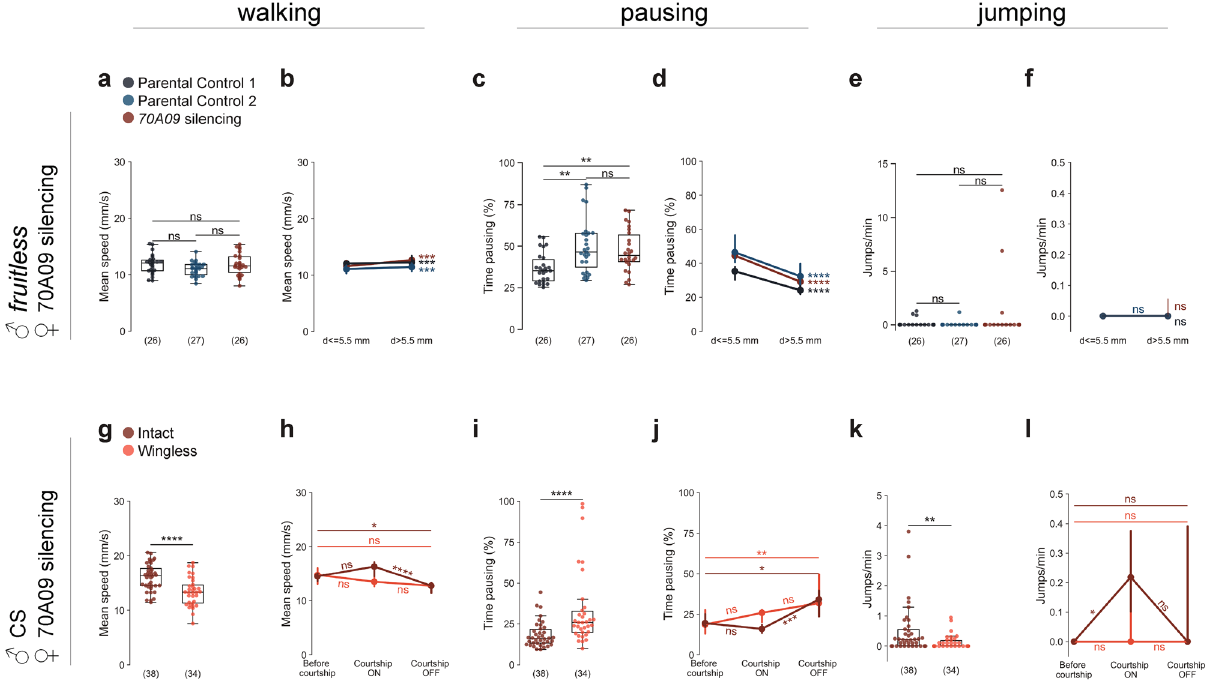
Figure 5. 70A09-silenced females do not escape when coupled with courtship-impaired males. ( a – f ) Non courting fruitless mutant males paired with females of each of the genotypes: w-/UAS > STOP > kir2.1; otd nls:FLPo/ + ; + (Parental Control 1), w-; + ; 70A09-GAL4/ + (Parental Control 2) and w-/UAS > STOP > kir2.1; otd-nls:FLPo/ + ; 70A09-GAL4/ + (70A09 silencing). ( g – l ) Canton-S males intact and with wings removed (wingless) paired with silenced 70A09 females (70A09 silencing). ( a and g ) Female mean walking speed (4–50 mm/s), ( c and i ) female pausing and ( e and k ) number of jumps per minute, during courtship ON periods. ( b and h ) Female mean walking speed (4–50 mm/s), ( d and j ) female pausing and ( f and l ) number of jumps per minute, in different moments of courtship dynamics. Statistical analysis was performed with one-way ANOVA followed by post hoc Tukey’s test ( a ), paired t-test ( b ), Kruskal–Wallis test ( c and e ) and Friedman’s test ( h , j and l ) followed by post hoc pairwise Dunn’s test with Bonferroni correction, Wilcoxon signed rank test ( d and f ), unpaired t-test ( g ) and Mann–Whitney U test ( i and k ): ns not significant, *p < 0.05, **p < 0.01, *** p < 0.001, ****p < 0.0001. n values are shown in